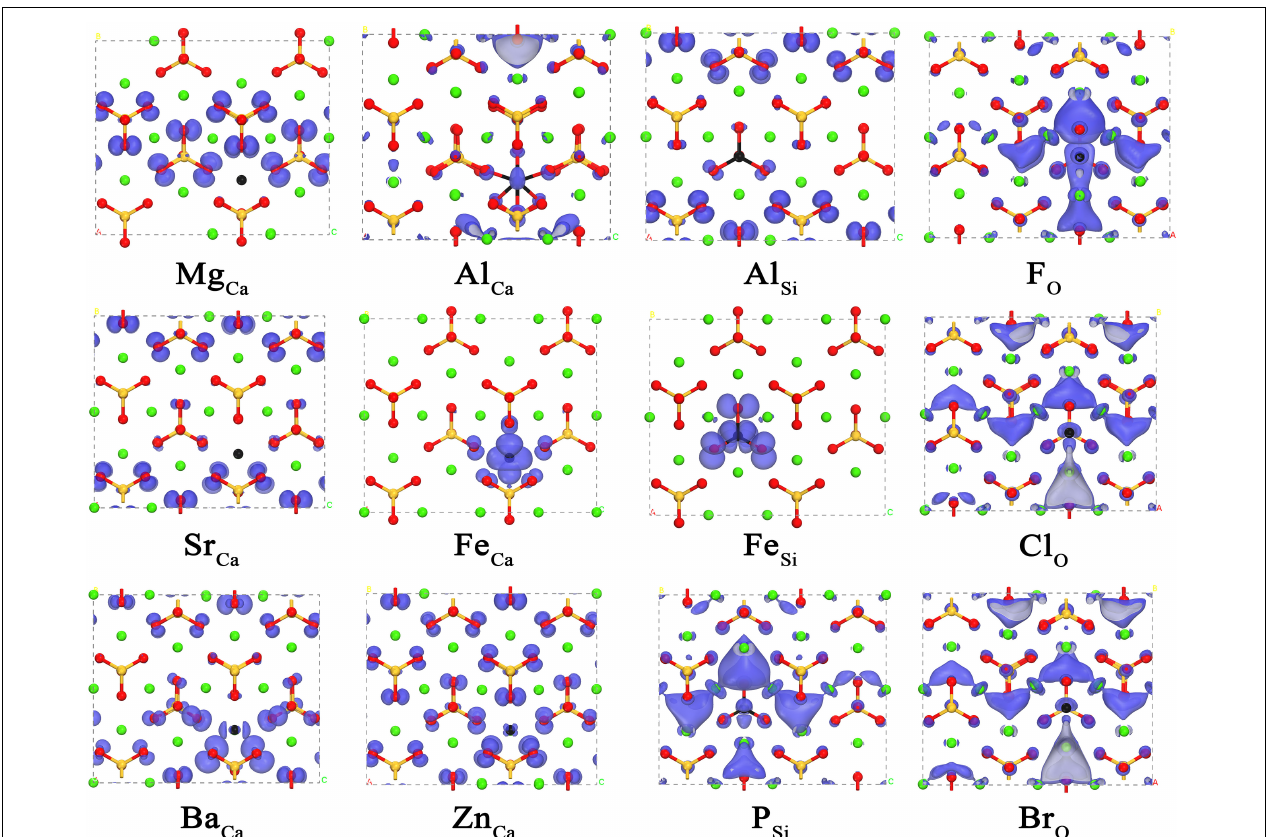
FIGURE 4 | The local charge density distribution of the valence band maximum of doped γ -Ca 2 SiO 4 crystals. The green, orange, red, and black spheres are Ca, Si, O, and dopant atoms, respectively.